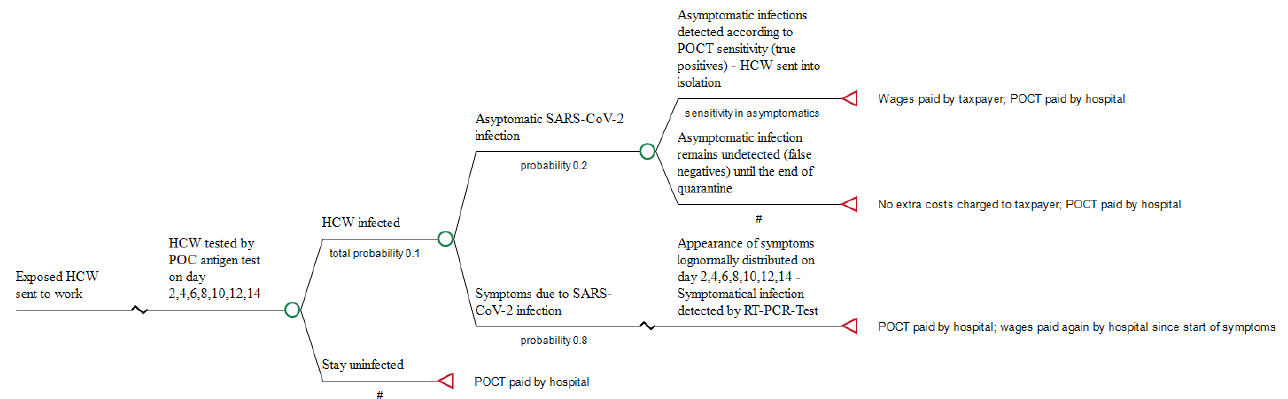
Figure 2. Pathway of sending exposed HCW to work (Scenario 2). #: Complementary probability (all probabilities of chance node’s branches to sum to 1.0).